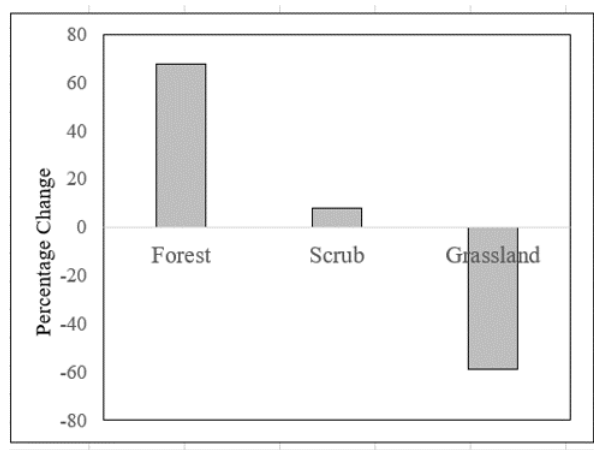
Figure 4: Percentage change (from the base year 2005) in the three major habitat types (forest, scrub, and grassland) in the Udawalawe National Park over 14